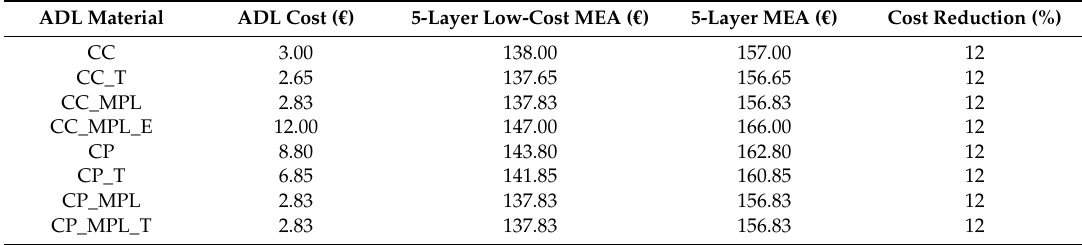
Table 4. Costs of the carbon-based materials tested as ADL, the 5-layer low-cost membrane electrode assembly (MEA) (3 mg / cm 2 Pt / Ru and 1.3 mg / cm 2 Pt), the 5-layer MEA (4 mg / cm 2 Pt / Ru and 4 mg / cm 2 Pt), and cost reduction using the low-cost MEA: active area 25 cm 2